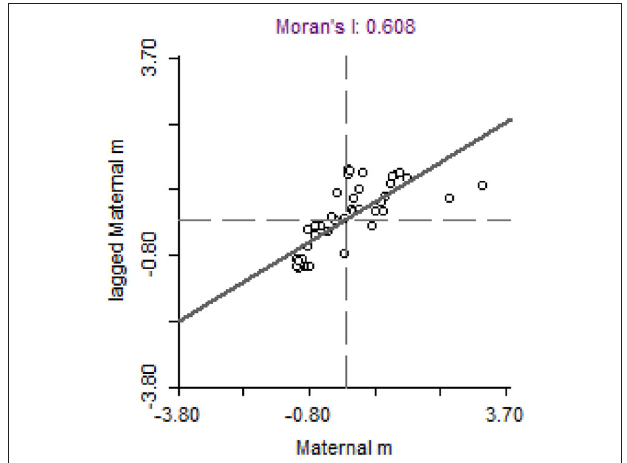
FIGURE 2 | Moran’s I statistics across